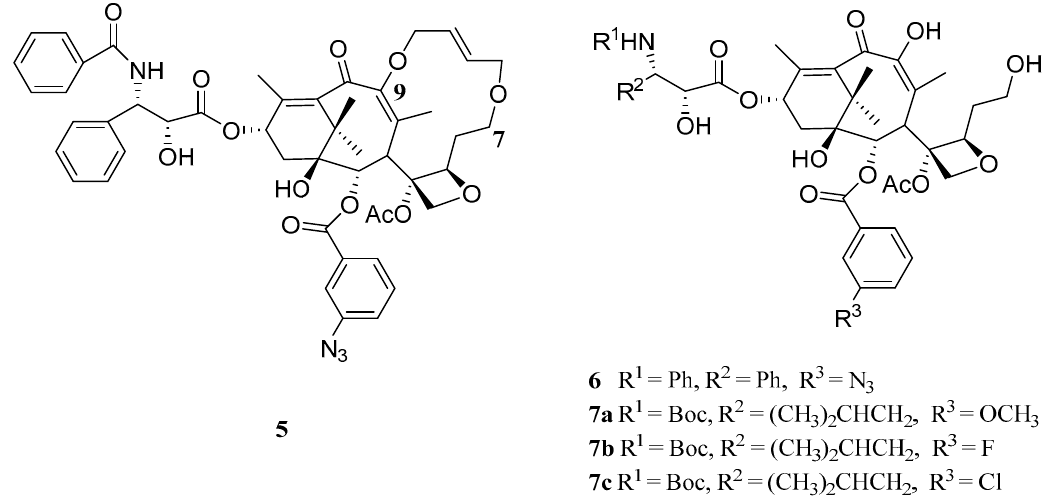
Figure 3. Structures of the 7,9- O -linked C-seco taxoid 5 and C-seco taxoids 6, 7a – c.